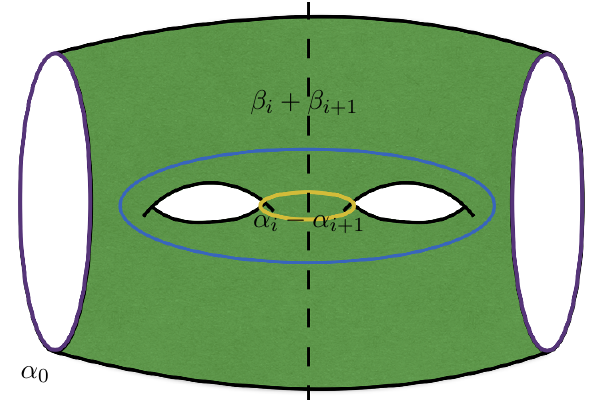
Figure 10 . The fundamental unit T 2 with cycles that are contractible in the phase of interest